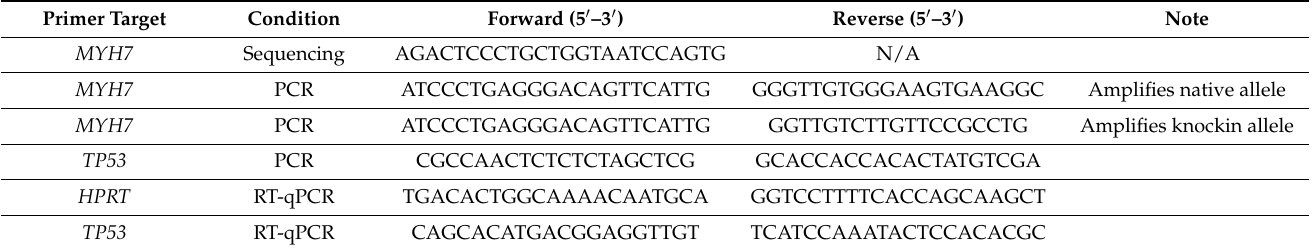
Table 3. Primer sequences for Sanger sequencing, PCR, and